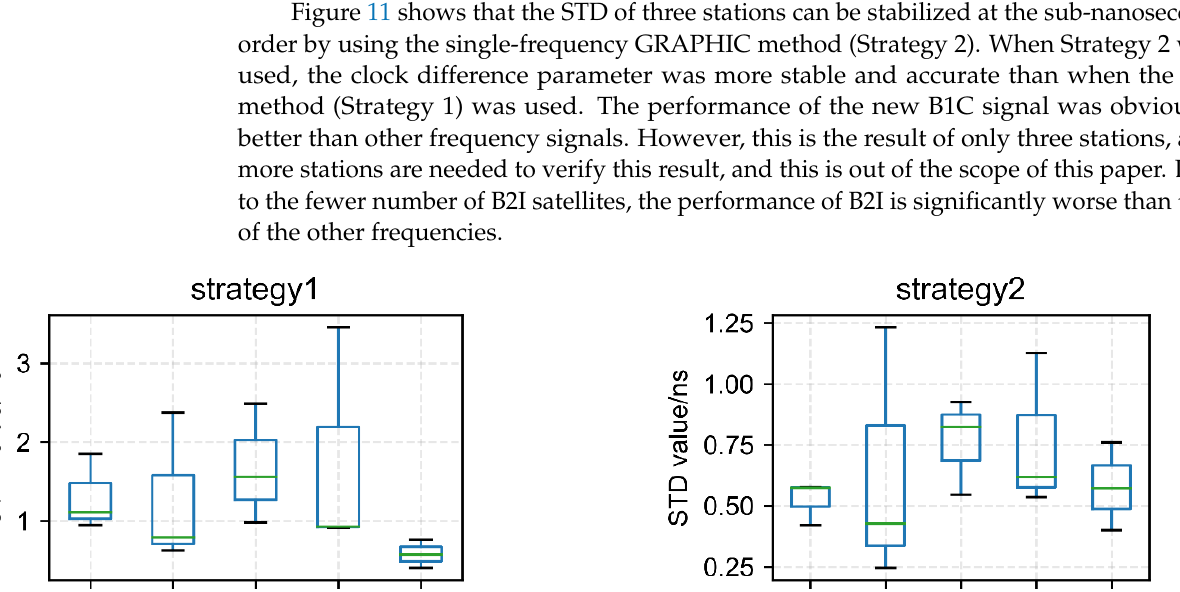
Figure 10. The results of clock difference statistics’ STD of two strategies of three stations (CUSV, HARB, WTZZ).